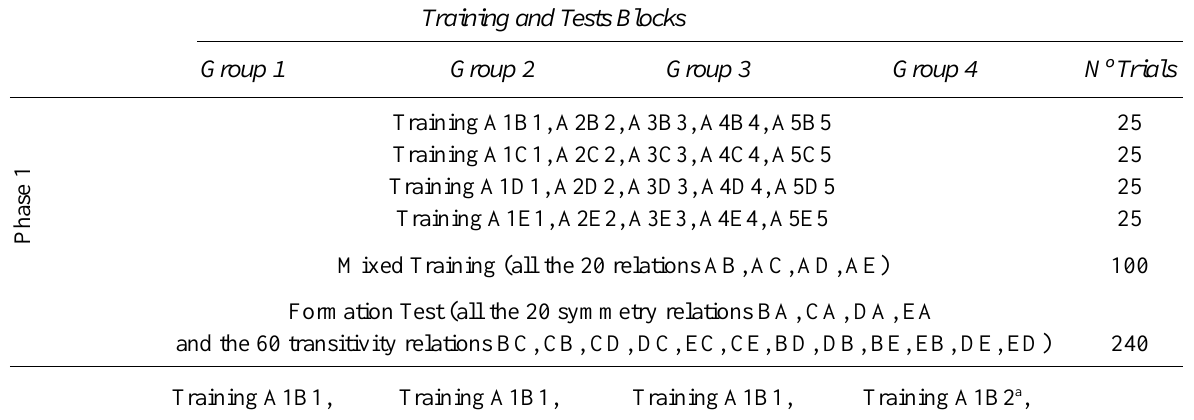
Distribution of Training and Tests Blocks, and Trained Relations in Each Phase of the Procedure and Number of Trials per